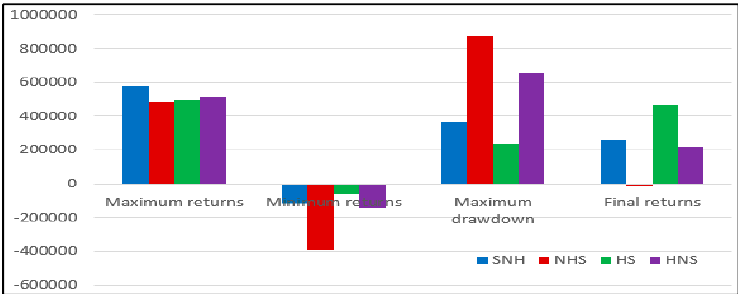
Figure 32. Comparison of four strategic situation column charts (25% after forecasting).